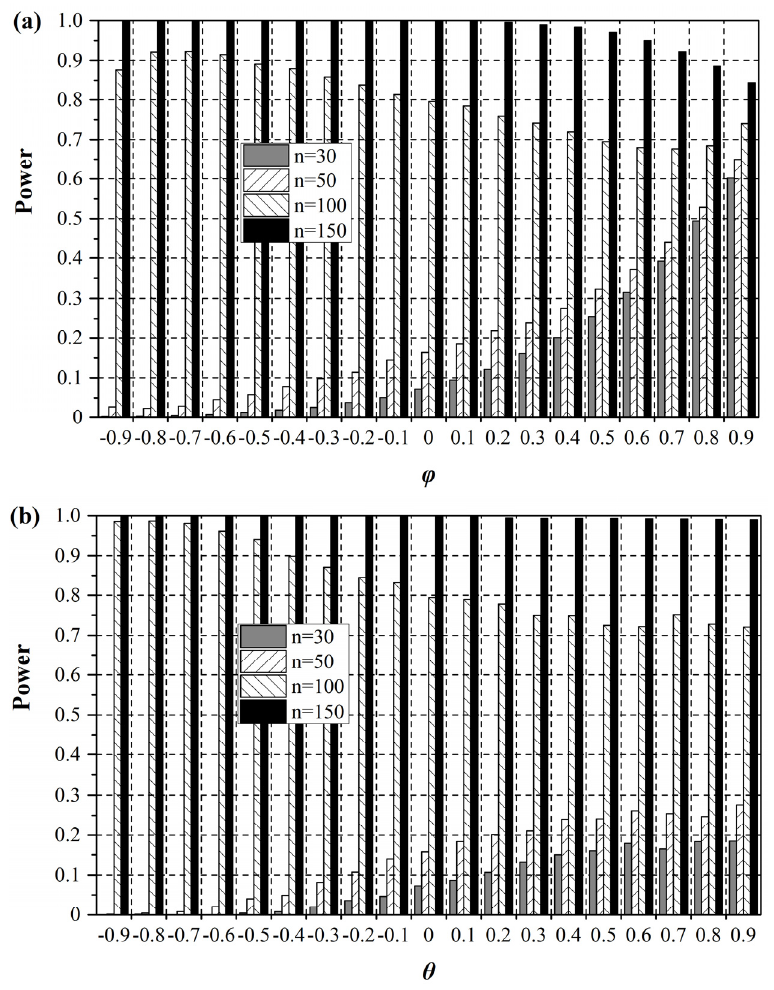
Figure 2. The effect of autocorrelation on the power (10,000 simulated sample series, σ x = 0.2, β = 0.002): ( a ) AR(1); ( b ) MA(1).